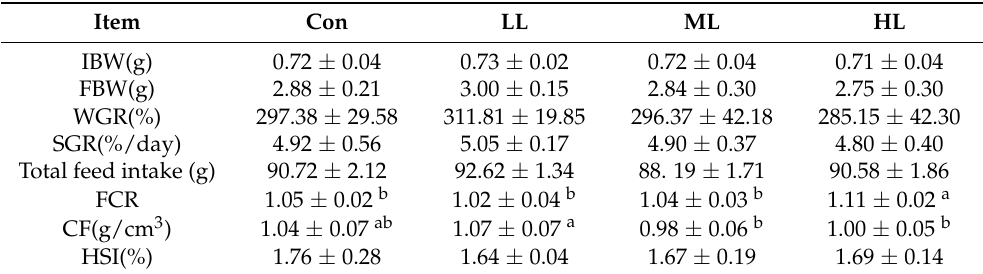
Table 3. Growth performance of juvenile largemouth bass fed the experimental diets for 28 days *.